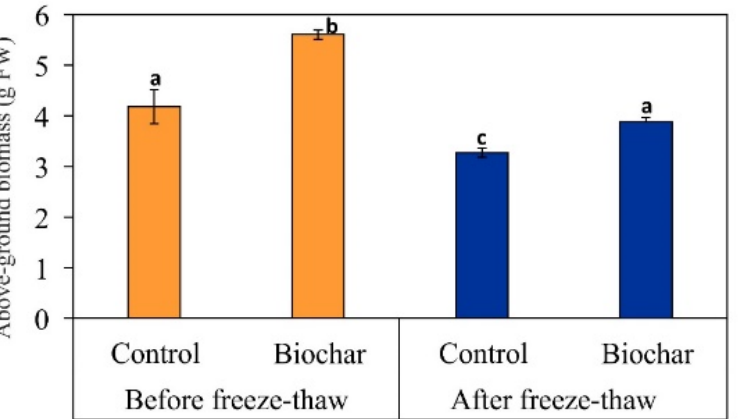
Figure 1. Effect of biochar amendment on above-ground biomass before and after freeze–thaw of a phytostabilized metal/metalloid-contaminated soil cultivated with Lolium perenne L. See Materials and Methods for detail on experimental set-up. Data are mean ± standard deviation ( n = 3). Values followed by different letters differ significantly (ANOVA followed by Tukey’s HSD test, p < 0.05).